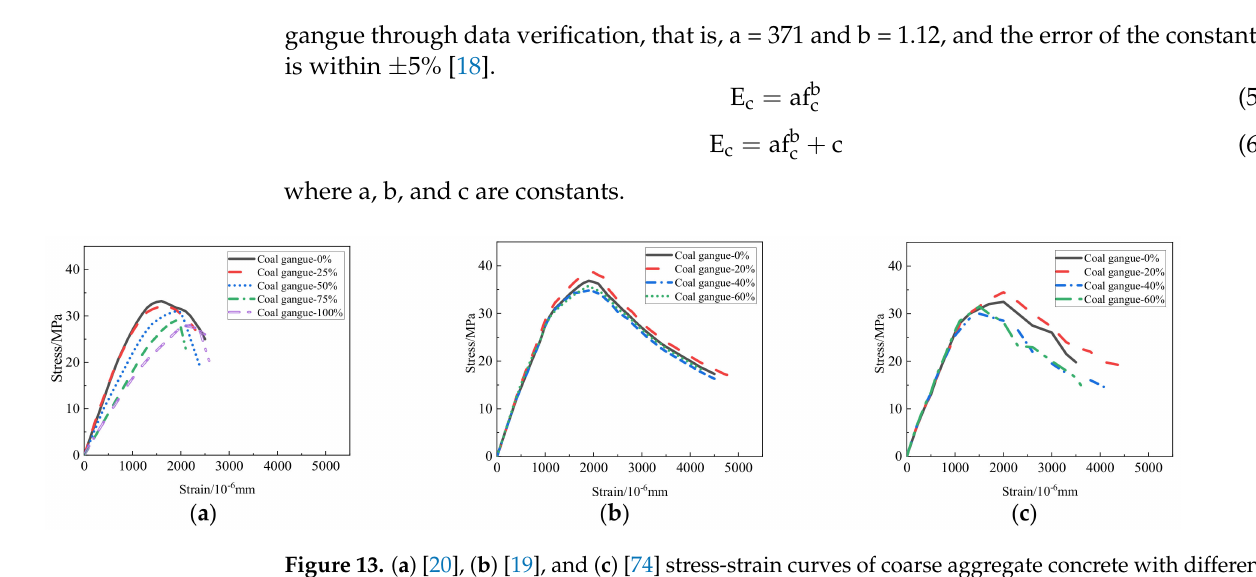
Figure 13. ( a ) [20], ( b ) [19], and ( c ) [74] stress-strain curves of coarse aggregate concrete with different gangue content.